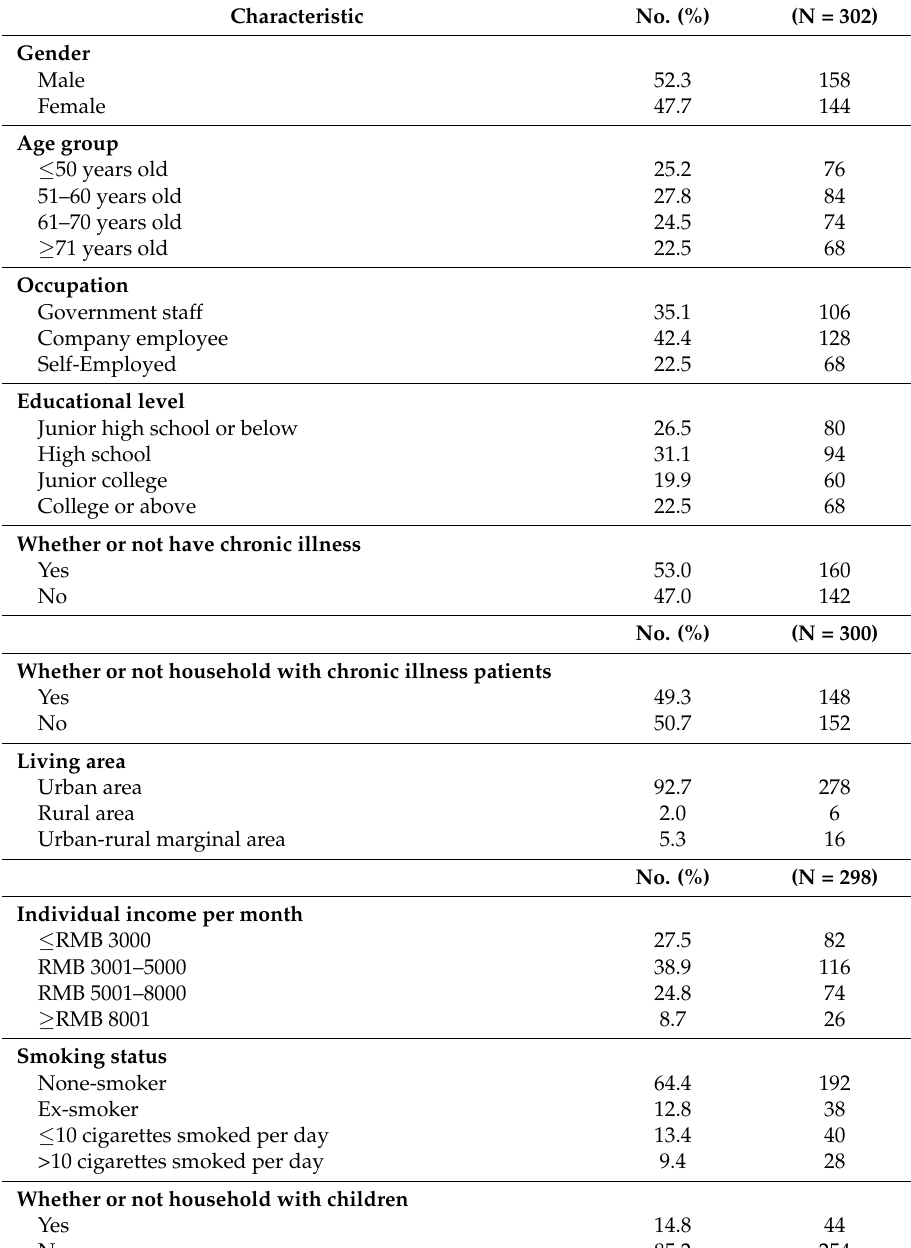
Table 1. Socio-demographic characteristics of the study